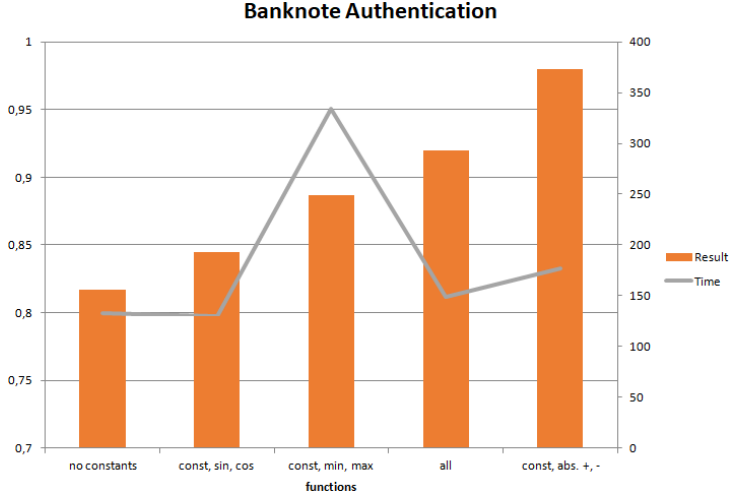
Fig. 7. Results obtained for di®erent functions used in the grammar describing Genes and Banknote Authentication dataset.